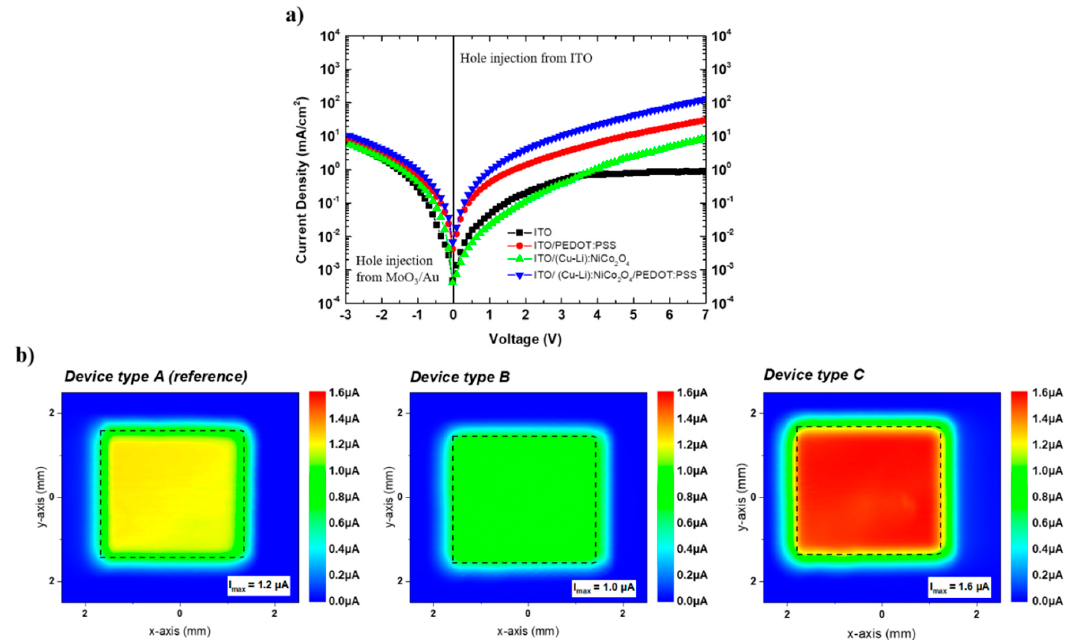
Figure 5. ( a ) JV characteristics of hole only devices with the structure of ITO / HIE / SY / MoO 3 / Au, ( b ) photocurrent maps of complete dual carrier 3 × 3 mm 2 type A, B and C OLED devices.